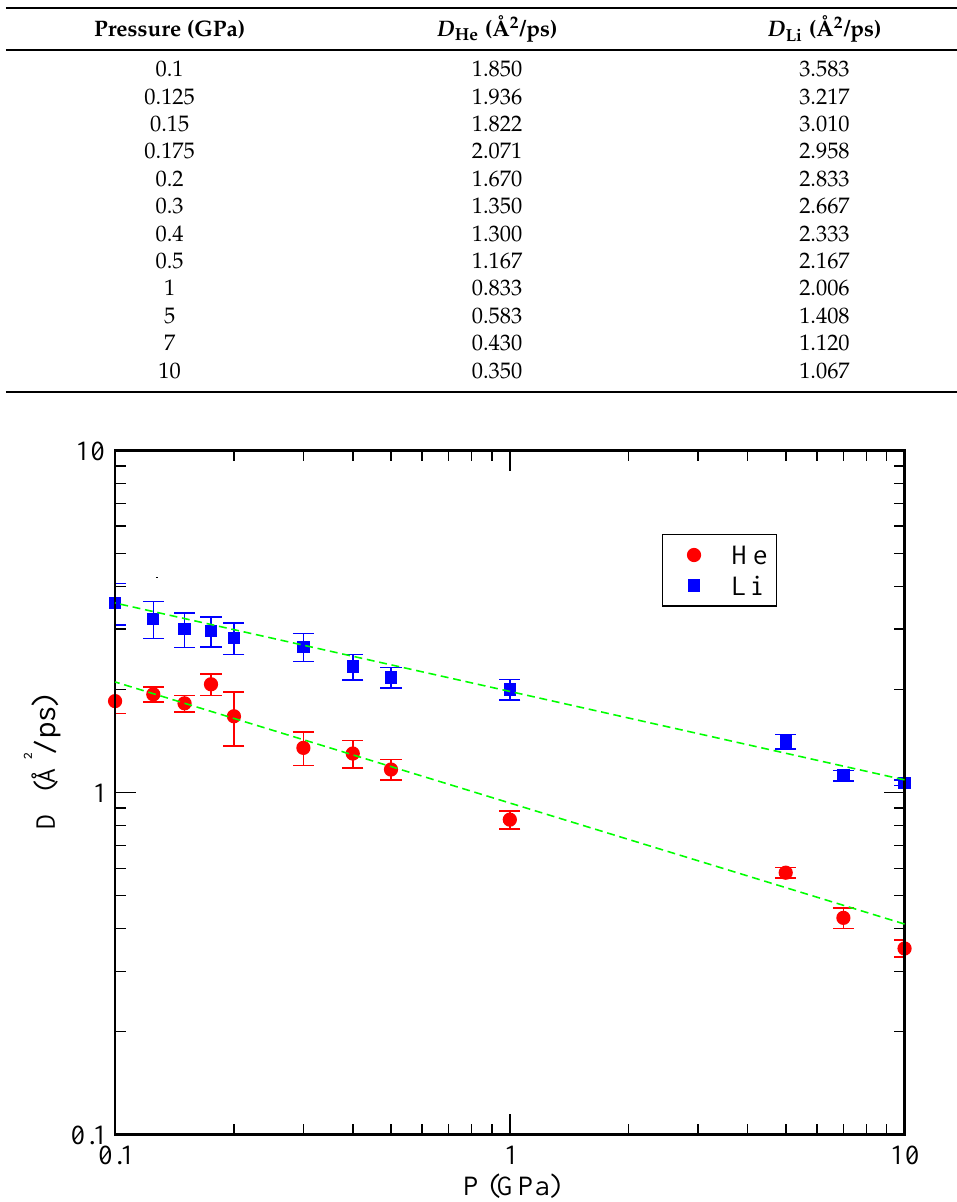
Figure 10. Diffusion coefficients of lithium (blue squares) and helium (red circles) at 800 K as a function of the pressure on a logarithmic scale. Green straight lines are a guide to the